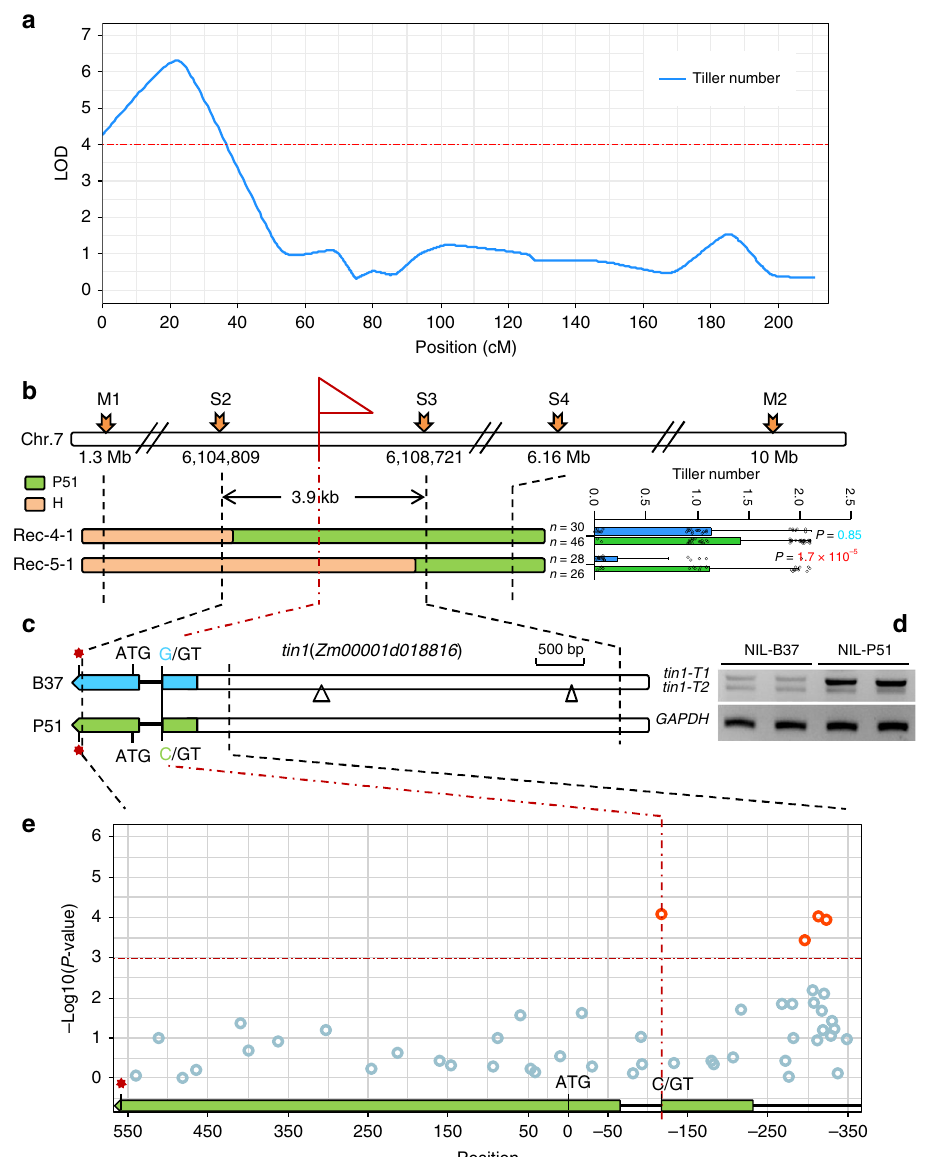
Fig. 3 High-resolution mapping of tin1 . a QTL mapping identi fi ed a major QTL, tin1 , on chromosome 7 for tiller number in a RIL population derived from crosses between an elite inbred line B37 and a sweet maize P51. The red dashed line represents the signi fi cant logarithm of the odds (LOD) threshold (3.99) at the 0.05 level. b Fine mapping narrowed down tin1 within a genomic fragment of 3.9 kb through a progeny test. Green and orange bars represent the chromosomal fragments from P51 and heterozygous plants, respectively. The P -values from the progeny tests were highlighted in red (signi fi cant) and blue (non-signi fi cant) using Student ’ s t -test. Error bar, SD ( n = 30, 46; 28, 26). Green and orange bars signi fi ed the chromosomal fragments from the P51 and heterozygous plants. Scale bar, 500 bp. c Only one gene ( Zm00001d018816 ) was placed in this fi ne-mapping region. Blue and green bars and black lines represented exons and introns, and blank box signi fi ed promoter region. Scale bar represents 500 bp. The splice-site variant from G/GT to C/GT was present in P51. Only two insertions over 100 bp were shown in the promoter region. Red star, stop codon. Triangle, insertion. d RT-PCRs for two transcripts, tin1-T1 and tin1-T2 . The transcript of a housekeeping gene GAPDH was used as the internal control. e Association mapping. Signi fi cant signals were highlighted in red and non-signi fi cant signals were marked in light blue. The gene structure of tin1 was shown and the start codon was regarded as position 0. The horizontal red dashed line represents signi fi ed the 5% signi fi cance threshold with Bonferroni correction for 48 tests. The source data underlying d are provided as a Source Data fi